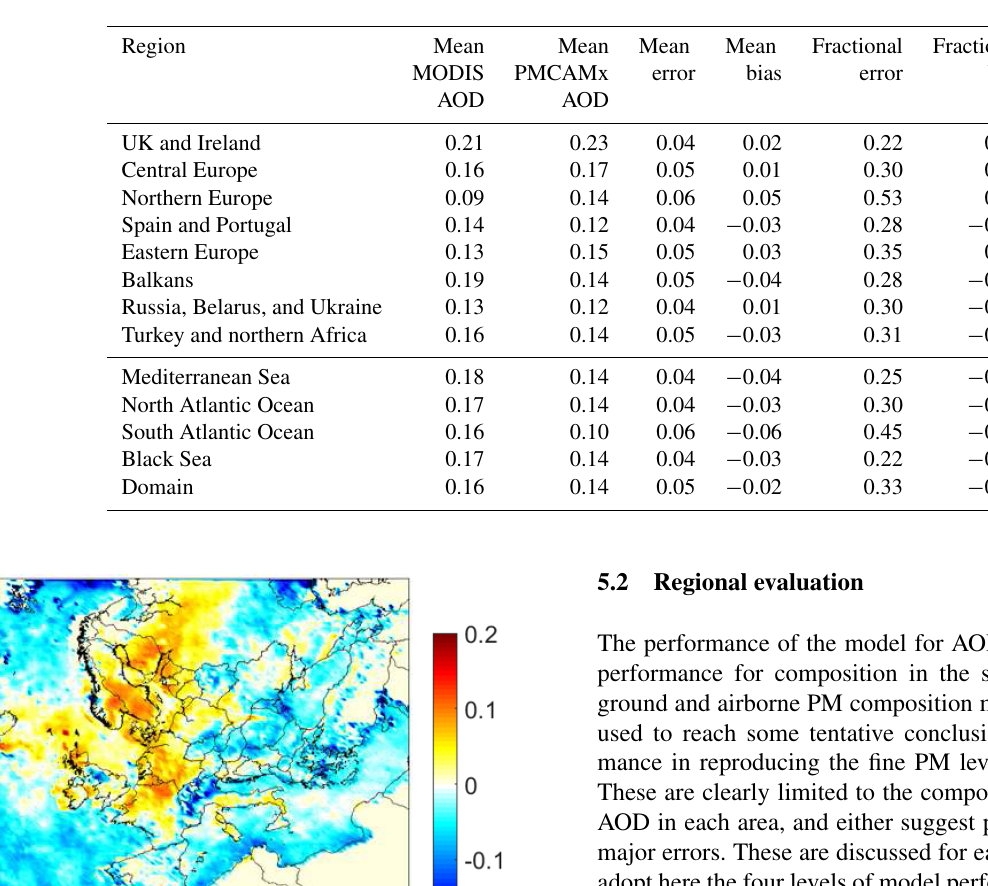
Table 2. Error metrics for the evaluation of PMCAMx against MODIS monthly mean AODs.